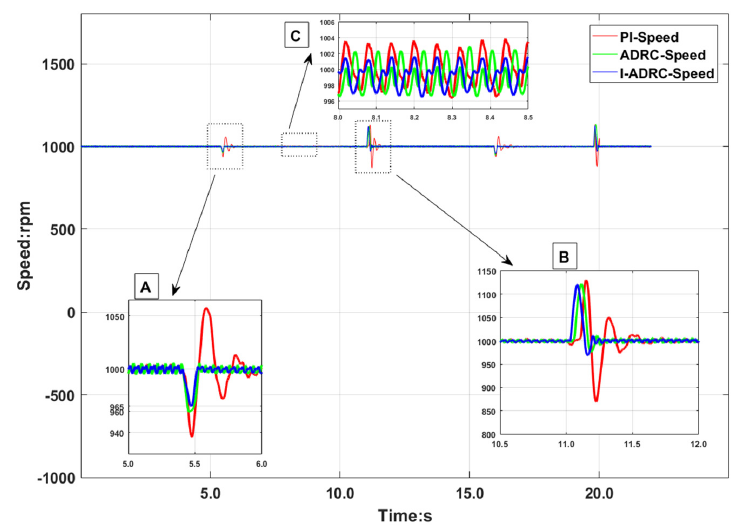
Figure 10. Load speed regulation test curve.